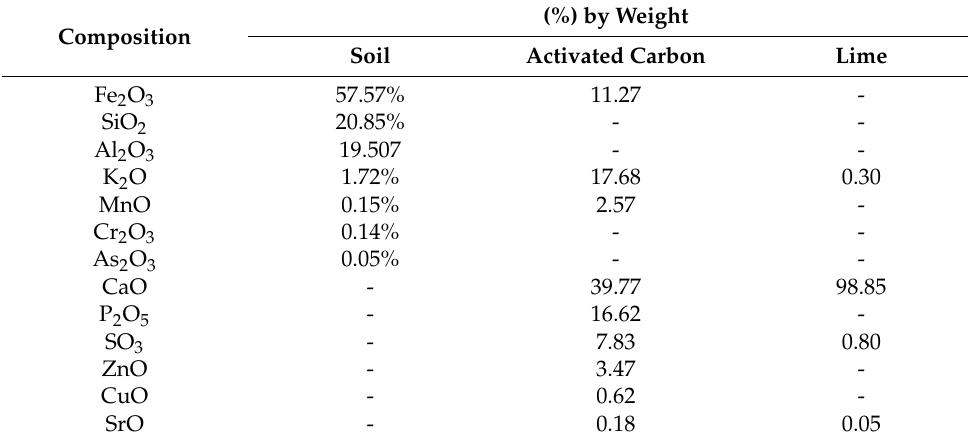
Table 2. Chemical composition of soil and